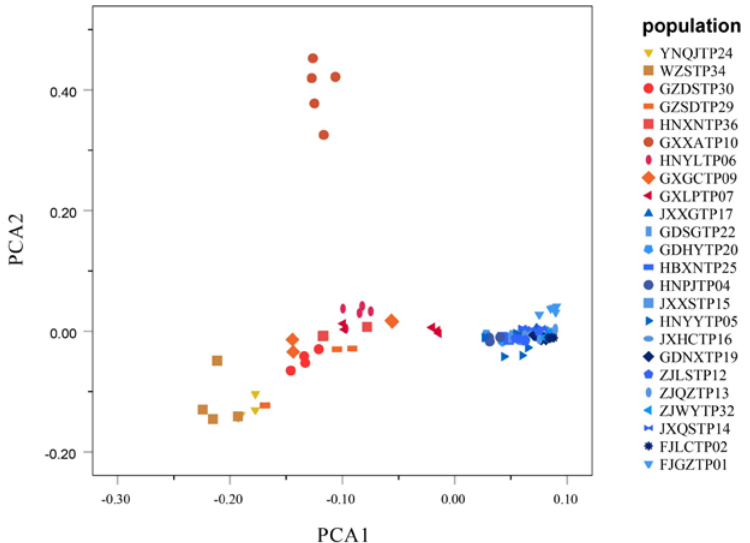
Figure 4. PCA of 109 samples in D. catenatum . Red shapes indicate Group I, while blue shapes indicate Group II.